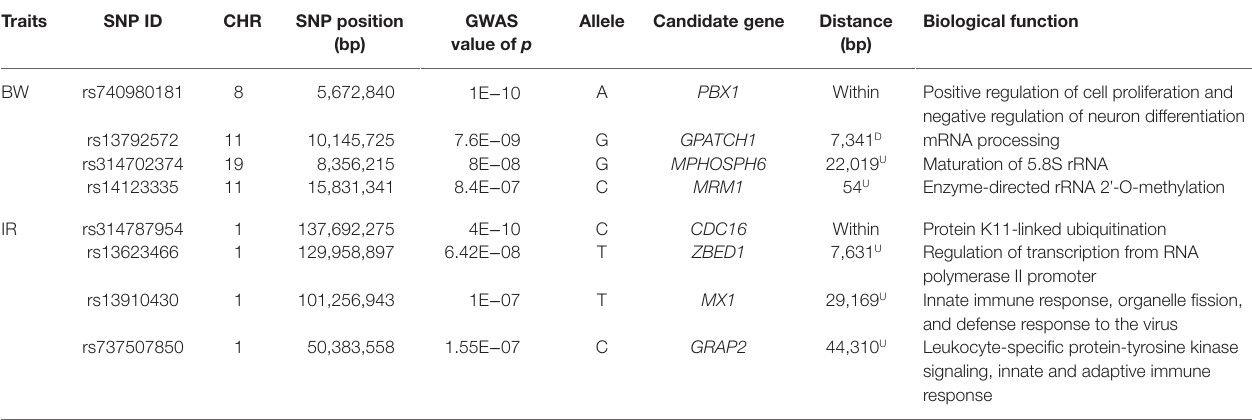
TABLE 2 | Summary of significant SNPs and nearest genes detected at false discovery rate of 5% for body weight and antibody response to Newcastle disease in indigenous chicken in Rwanda. Traits SNP ID CHR SNP position